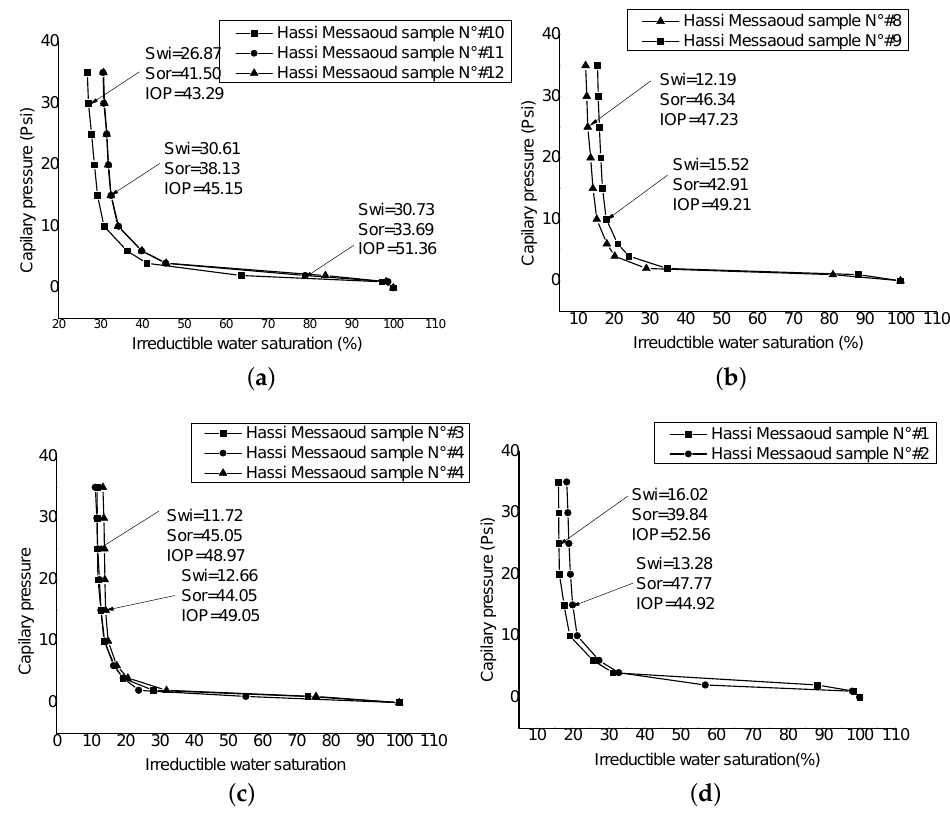
Figure 12. Capillary pressure versus the irreducible water saturation highlighting the impact of capillary pressure on the Sro, Swi and IOP for ( a – d ) different rocks from the oil